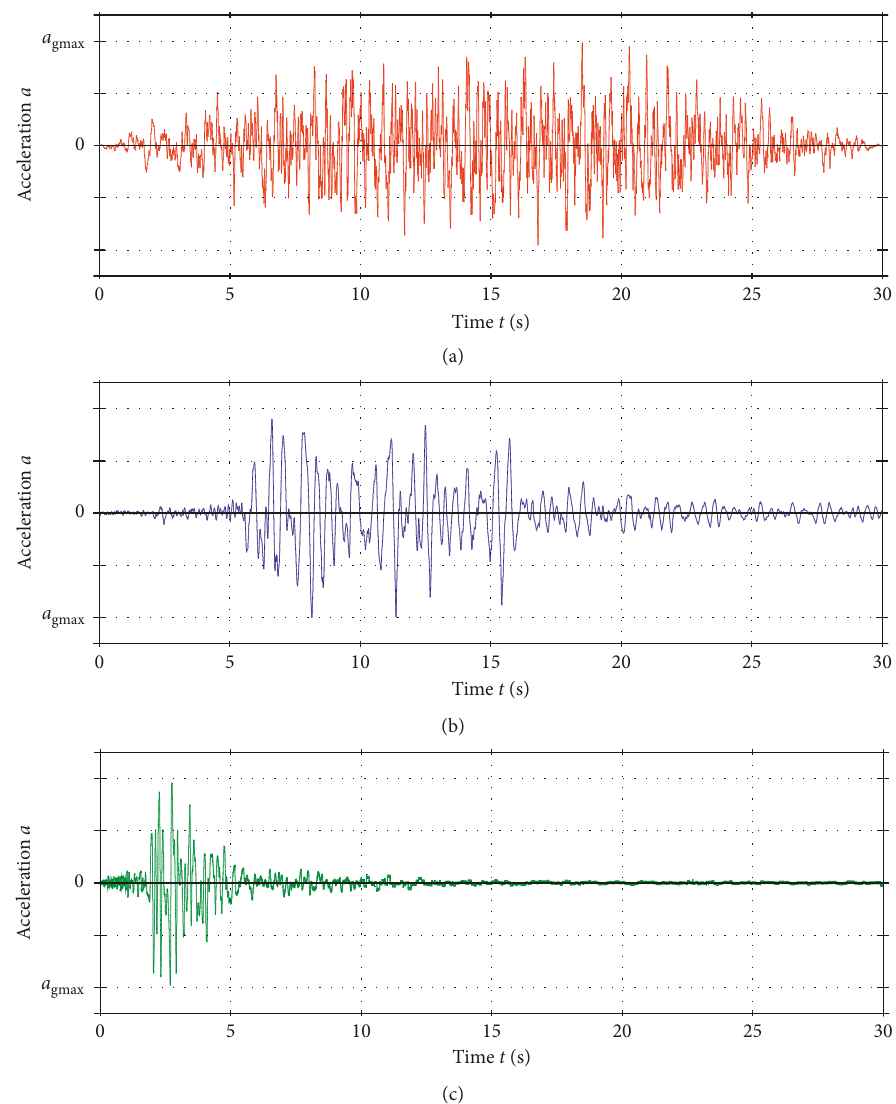
Figure 2: Applied horizontal base accelerations: (a) artificial accelerogram; (b) Petrovac accelerogram; (c) Ston